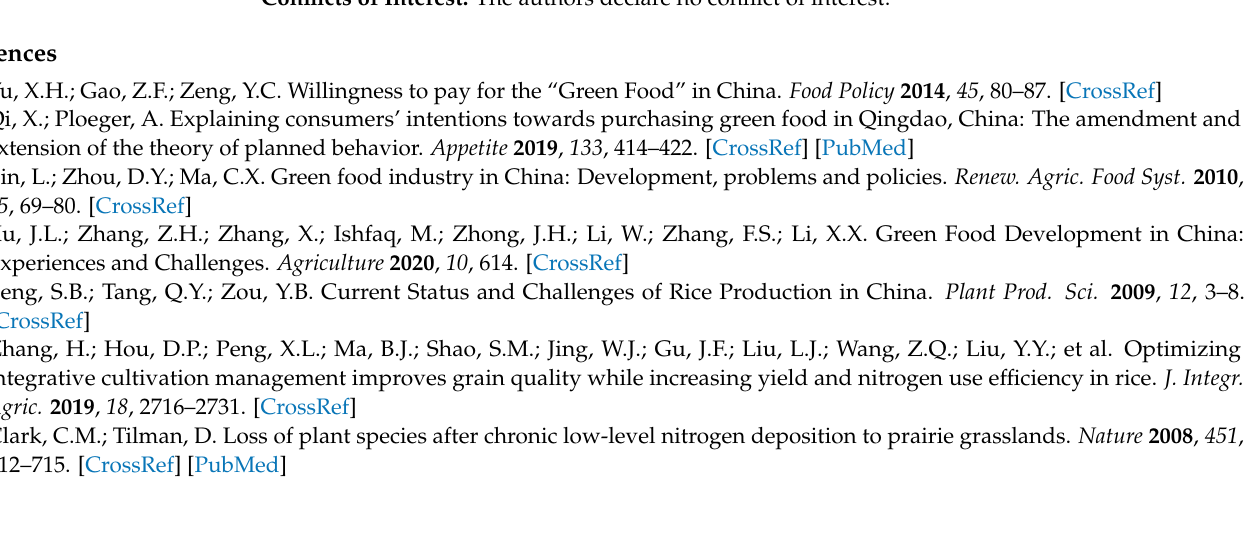
rice. Figure S1: PCA score plots derived from non-targeted metabolite profiling of three different treatments analyzed by